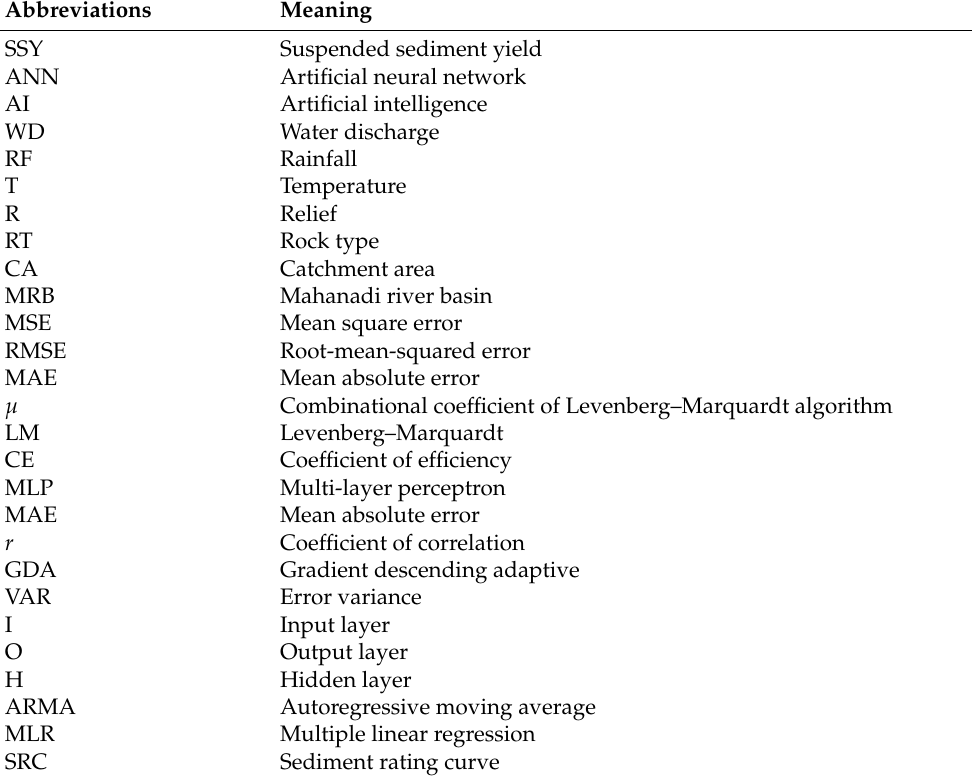
Table 2. List of abbreviations with